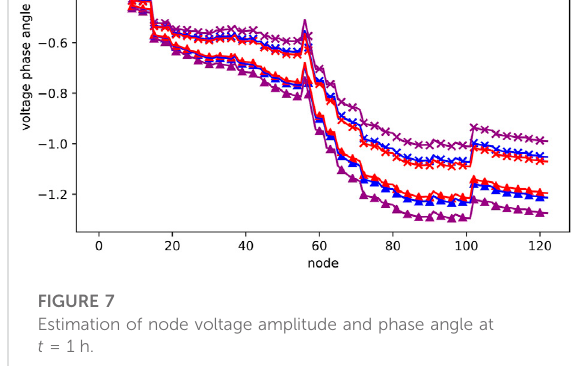
FIGURE 7 Estimation of node voltage amplitude and phase angle at t = 1 h. FIGURE 8